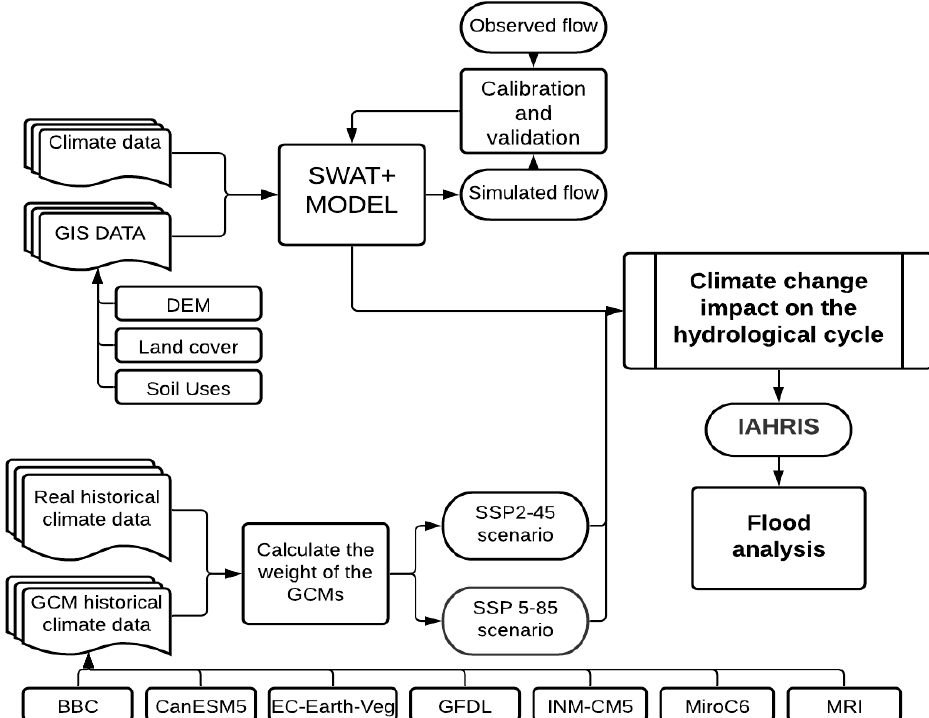
Figure 1. Flowchart of the approach underlying this investigation.